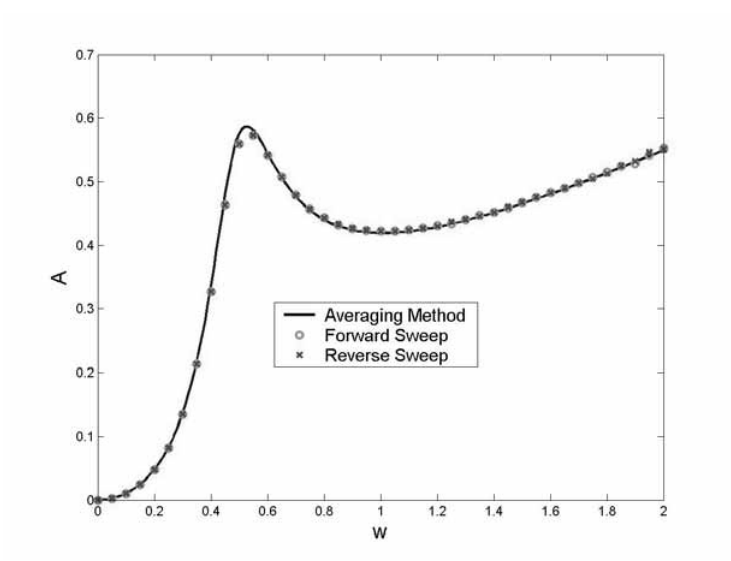
Fig. 9. Absolute engine mass